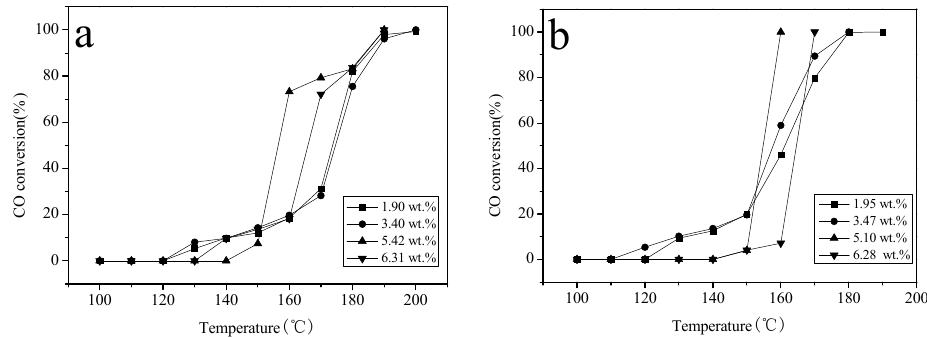
Figure 8. Catalytic activities of CuO/Bi 2 WO 6 ( a ) and CuO/Bi 2 WO 6 ‐ 400 ( b ) with different Cu ‐ contents.